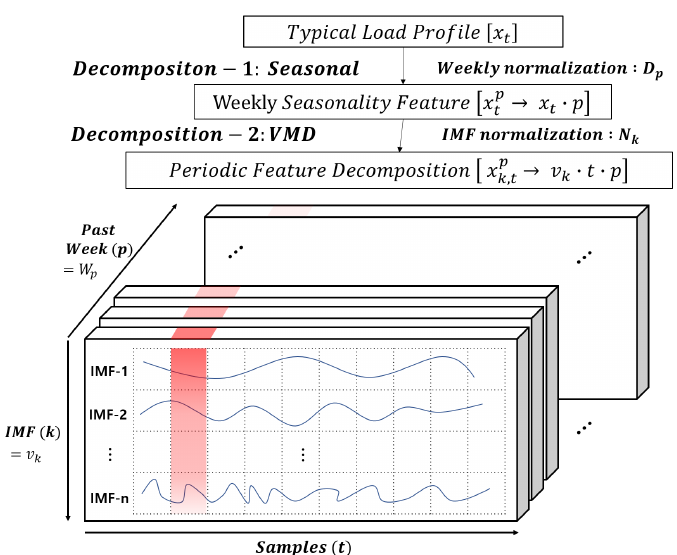
Figure 1. Load profile feature decomposition